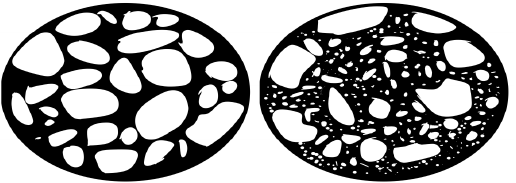
Figure 1. Typical SMA mixture ( left ) and dense-graded mixture ( right